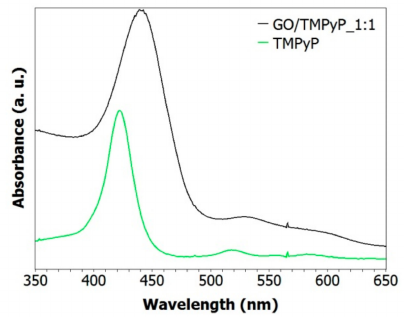
Figure 2. UV–vis absorbance spectrum of GO / TMPyP compared to TMPyP and GO alone. There is an obvious red shift of the Soret band from 417 nm (TMPyP) to 4375 nm (GO / TMPyP 1:1).